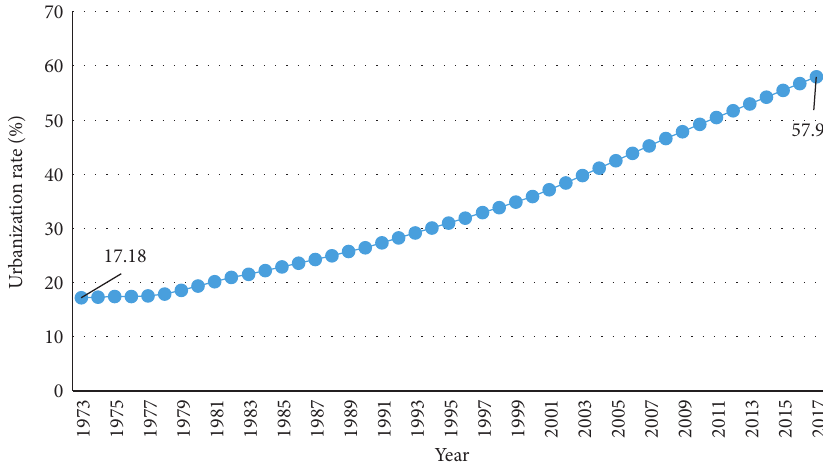
Figure 2: Chinese urbanization rates over the years.